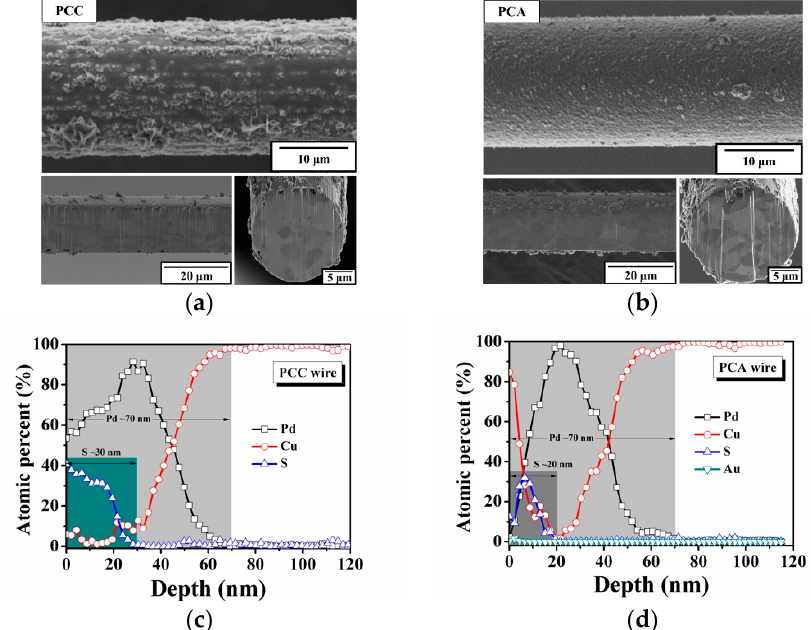
Figure 1. ( a ) ( b ) Surface morphologies, cross-section images, and ( c ) ( d ) depth profile of the PCC and PCA wires after the sulfidation for 4 h.